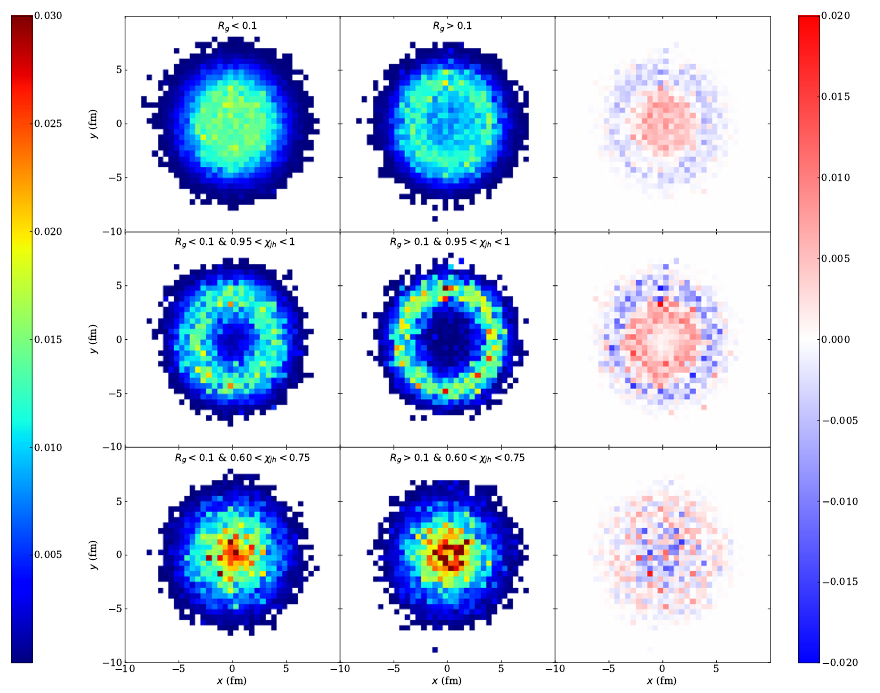
Figure 20 . The normalized distribution of the creation point in the transverse plane for jets with measured R 0 . 1 (left column) versus R 0 . 1 (middle column), and their difference g < g > (right column). Jets are required to have p 100 GeV and are inclusive in χ (upper row), in T > jh unquenched class with 0 . 95 < χ 1 (middle row) and quenched class with 0 . 6 < χ 0 . 75 jh < jh < (lower row). Regression of χ could be achieved by the neural network, while the production points jh are inputs from the hybrid